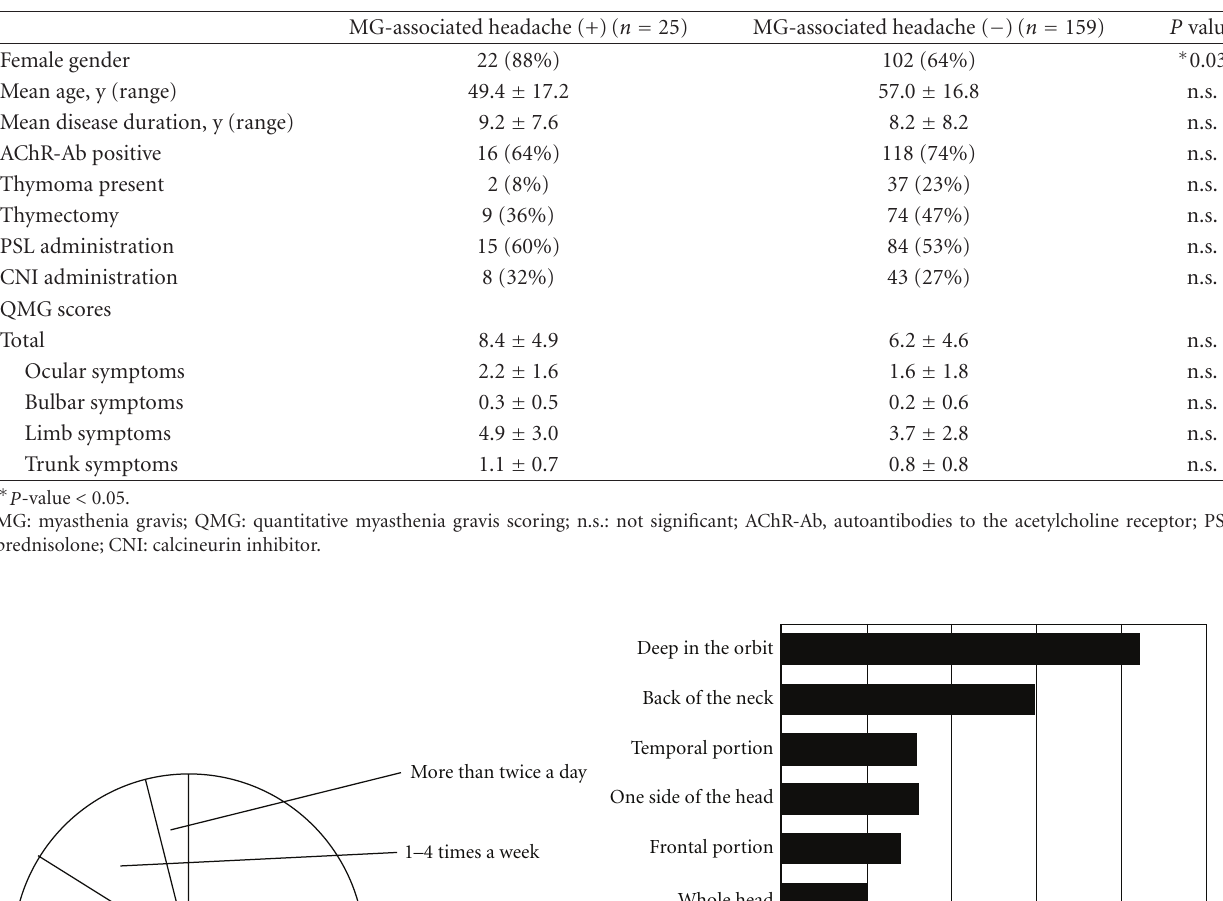
Table 1: Demographic and clinical features of patients with MG-associated headache.